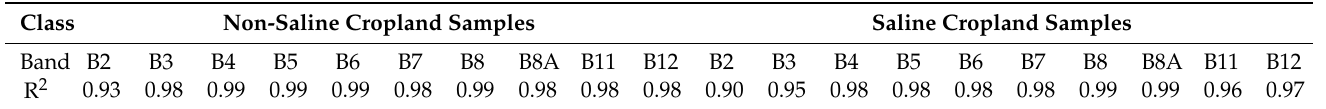
Table 2. R 2 values between normal data quantiles and normal theoretical quantiles of samples for the various bands of the Sentinel-2